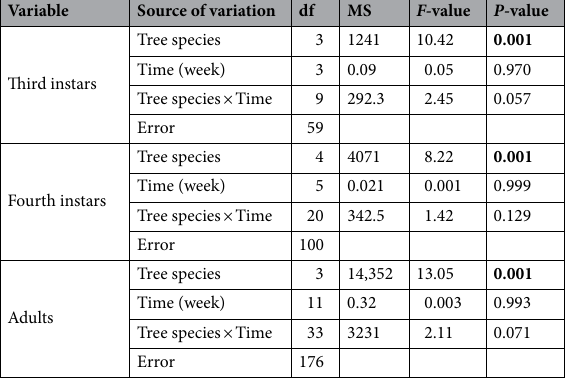
Table 2. Repeated measures binomial GLM ANOVA for analysis of data on the effect of tree species and time (week) on the proportion of Lycorma delicatula nymphs and adults present on individual trees in cages without Ailanthus altissima. df, degrees of freedom; MS, mean squares. Statistically significant values are indicated in